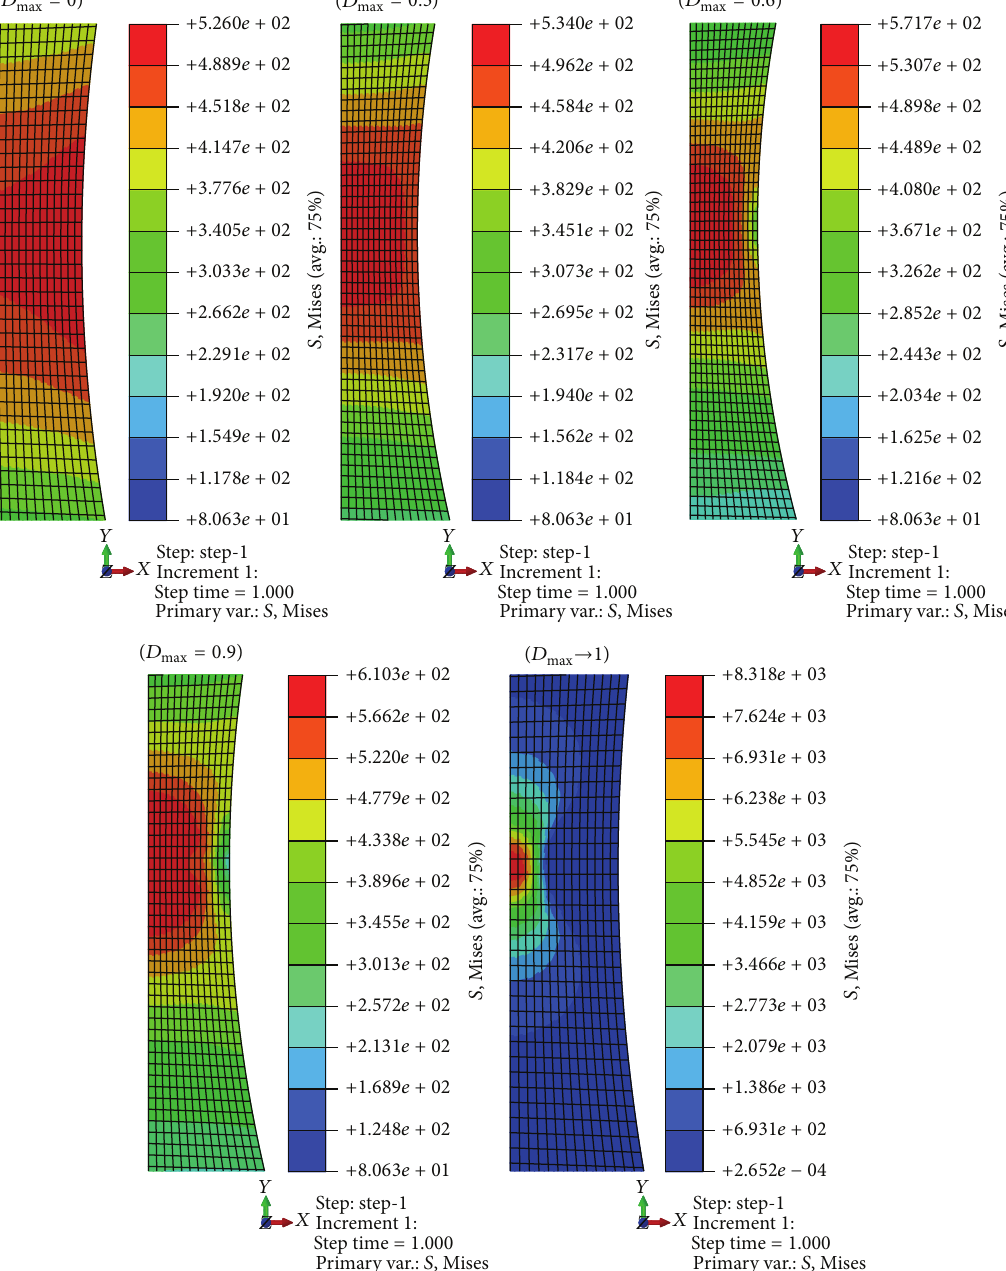
Figure 3: Stress changing of smooth specimen during damage